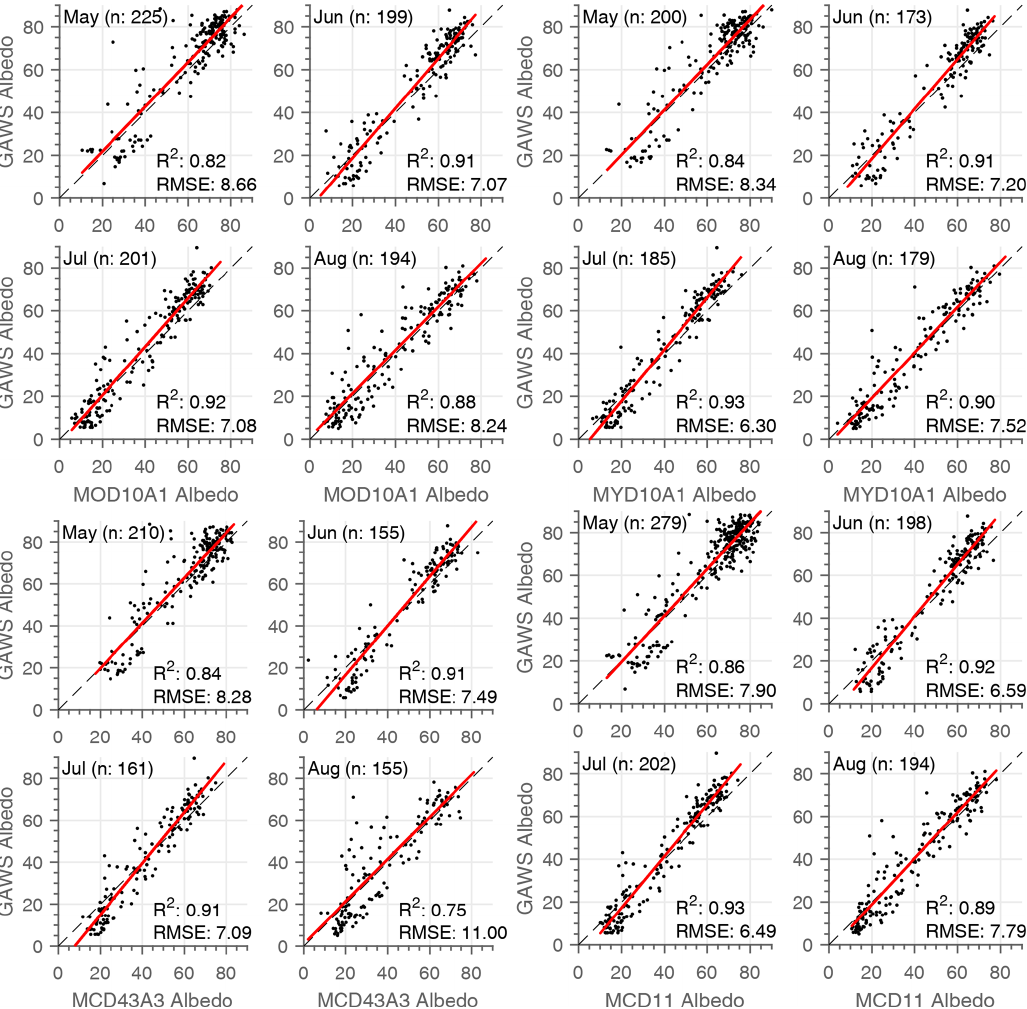
Figure A2. Albedo comparison results from monthly averaged MODIS data for May, June, July, and August for the period from 2000–2019 where data were available for MOD10A1, MYD10A1, MCD43, and MCD11 data